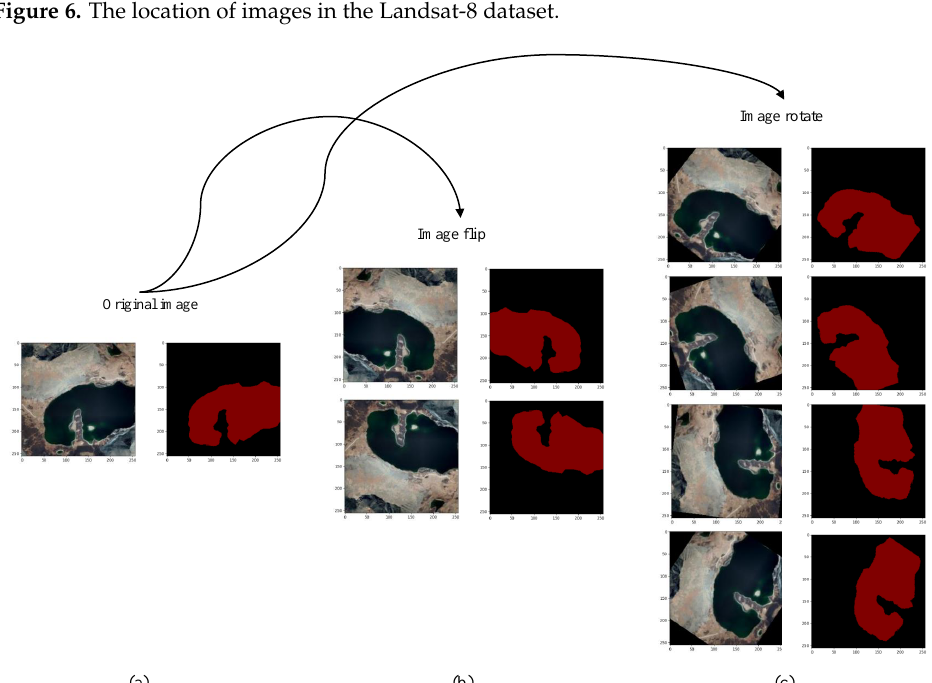
Figure 7. Part of the results for data augmentation on the original image and GT label. ( a ) Original image; ( b ) Image flip up to down and left to right; ( c ) Image rotate at any angle of (0 ◦ , 90 ◦